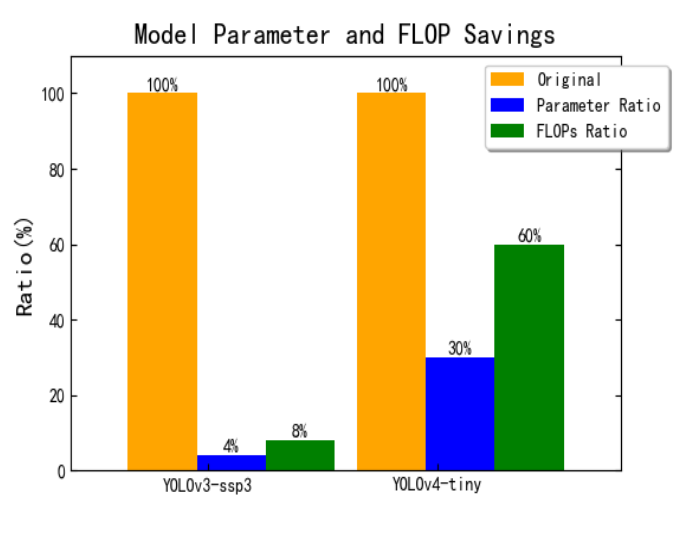
Figure 6. The effects of various pruning percentages with YOLOv4-tiny trained on NWPU VHR-10.